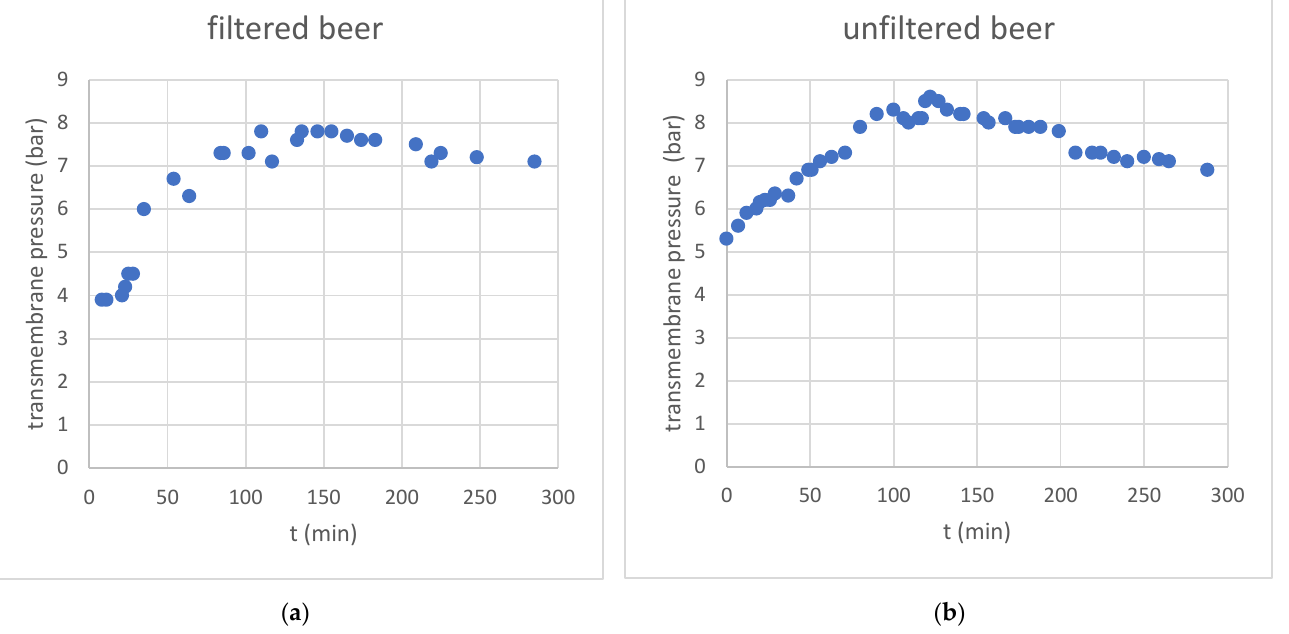
Figure 2. Transmembrane pressure of the beer dealcoholization process (concentration and diafiltration) at constant permeate flux rate for ( a ) filtered beer and ( b ) unfiltered beer.